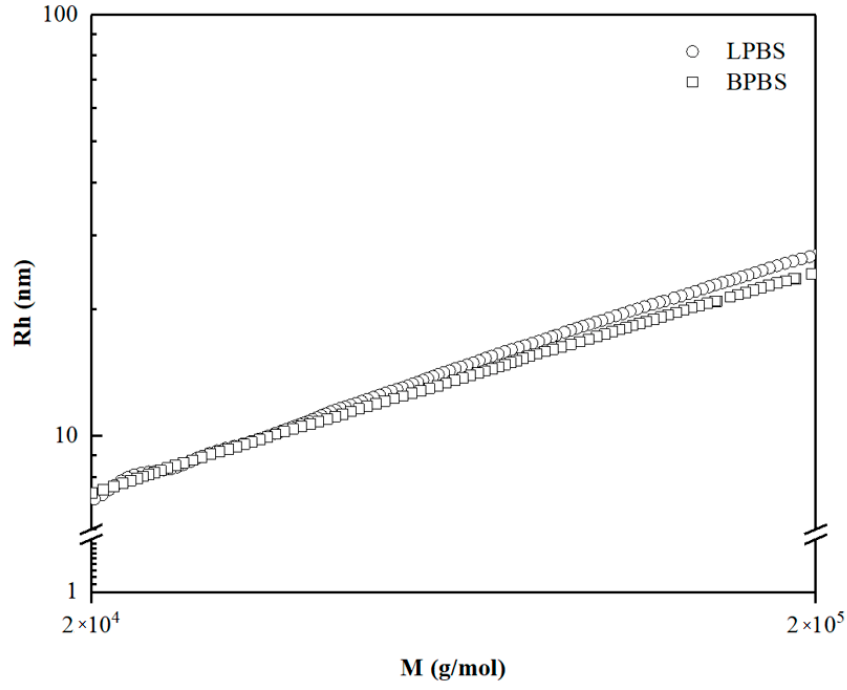
(cid:3) ) and LPBS ( (cid:35)